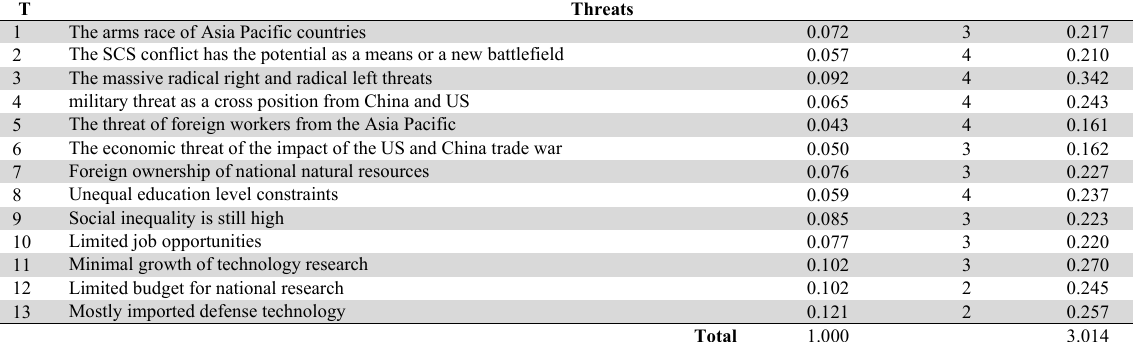
Scores and Weights for External Factors on Threat/Constraint Aspects T